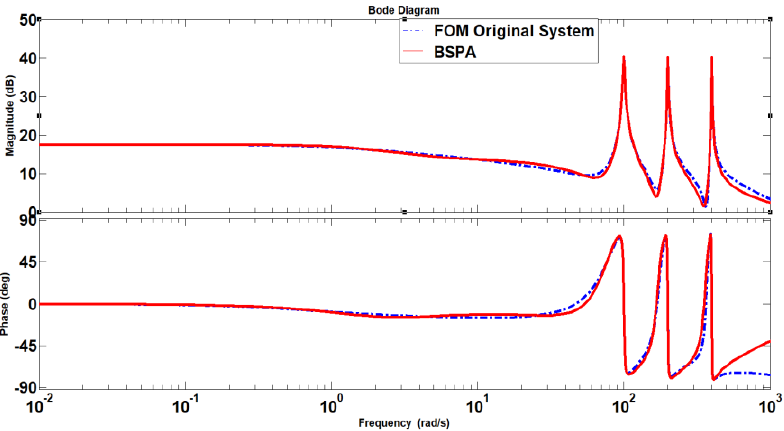
Figure 6. Frequency response of ROM with